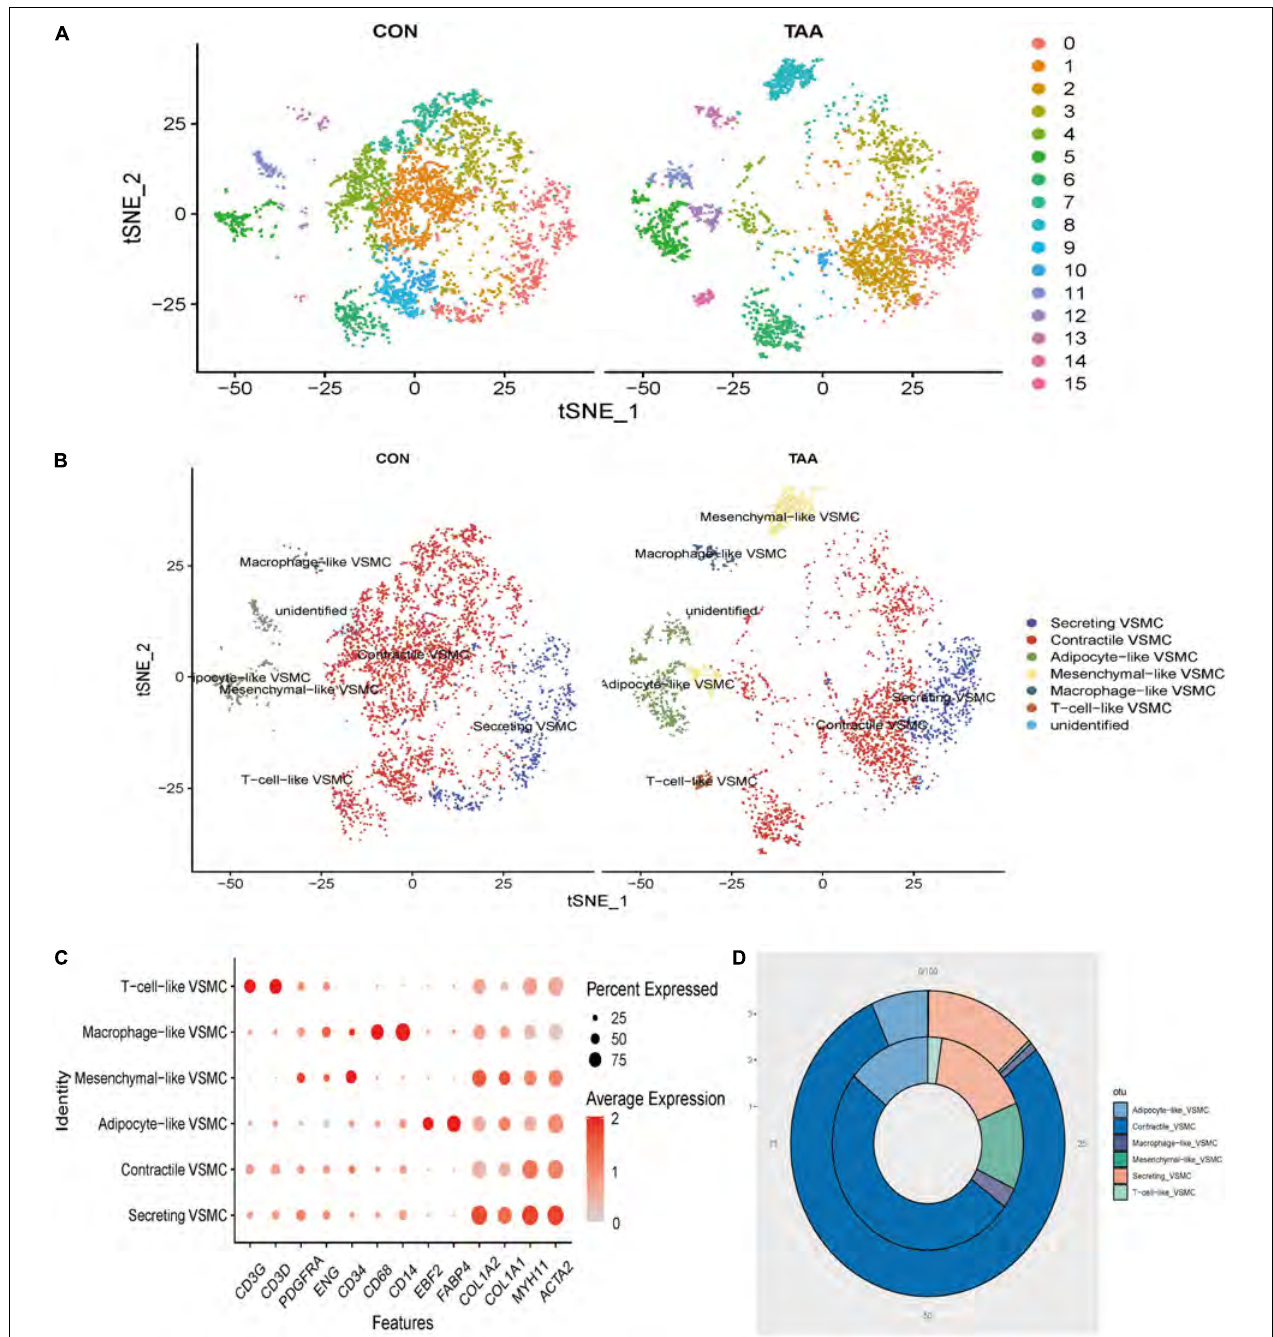
FIGURE 2 | Reanalysis of VSMC subtypes. t-SNE of identified 16 cell clusters (A) , which were then annotated as six VSMC phenotypes (B) . The expression level and expression percentage of specific marker genes were illustrated on the dot plot (C) . The proportion of monocyte, B cells, T cells, and macrophages was increased in aortic aneurysms (inner donut), while the proportion of smooth muscle cells, fibroblasts, and HSC was higher in the normal aorta (outer donut) (D)